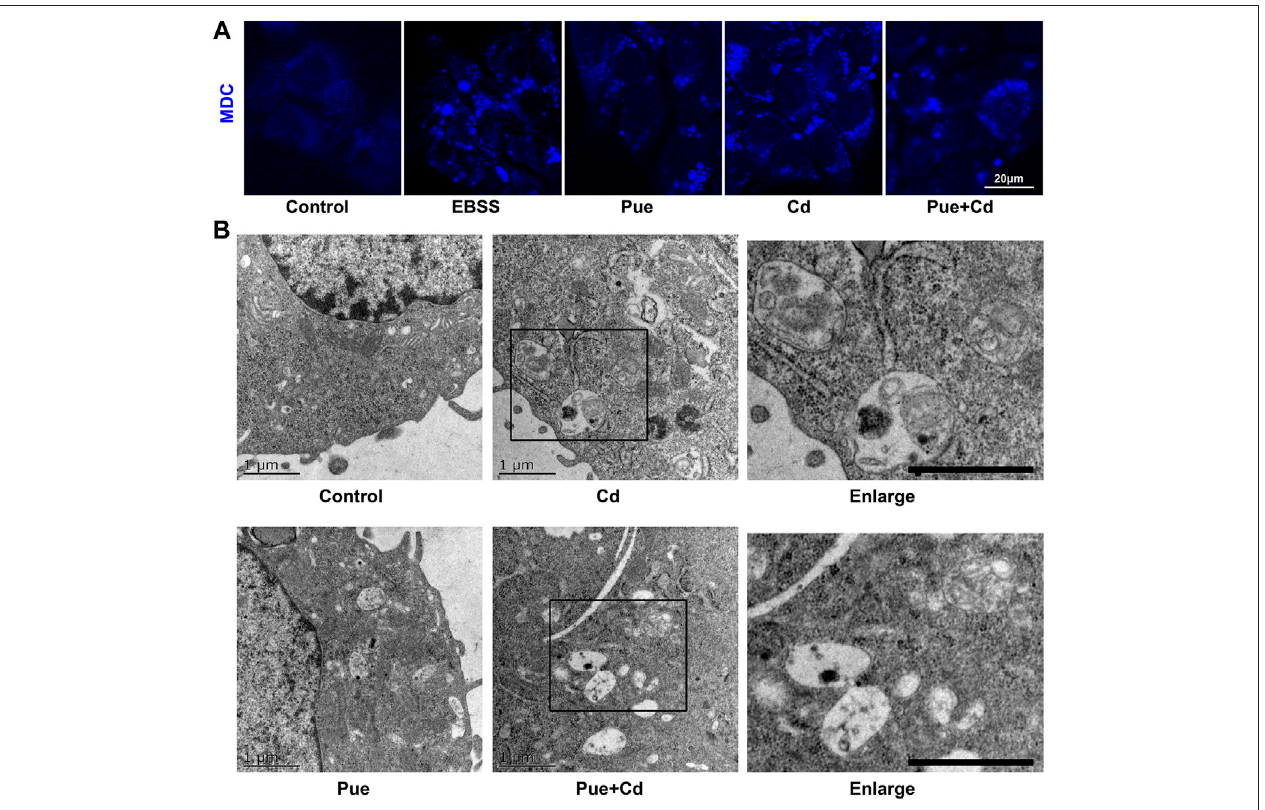
FIGURE 2 | Pue activated autophagy and alleviated Cd-induced accumulation of autophagosomes in AML12 cells. (A) Cells were treated with Pue and/or Cd for 12 h,andthentheautophagy levelswereanalyzedusisngMDCstaining.RepresentativeimagesofMDCstainingareshown.Scalebar (cid:2) 20 μ m. (B) Aftertreatment with Pue and Cd, alone or in combination, for 12 h, images of autophagosomes and autophagolysosomes were captured under a transmission electron microscope. Representative images of autophagosomes and autophagolysosomes are presented. Scale bar (cid:2) 1 μ m.